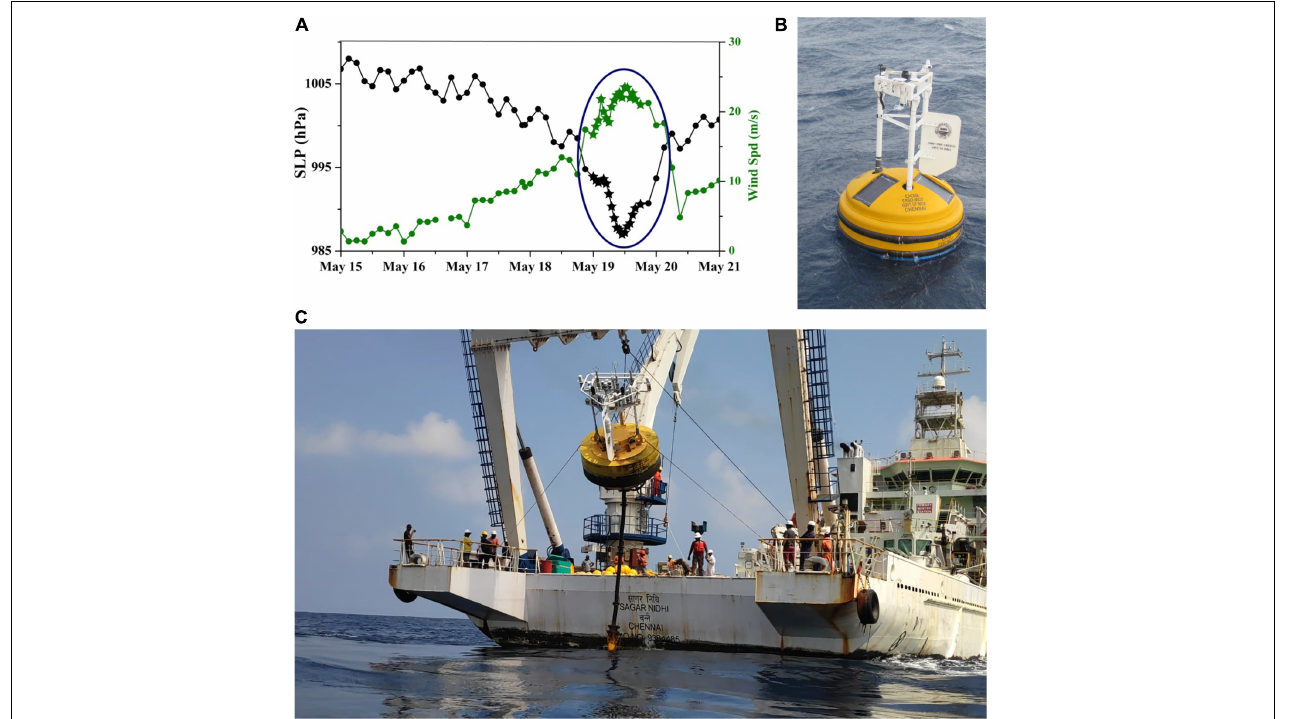
FIGURE 9 | (A) Time-series observations of air pressure and wind speed with high-frequency real-time data during cyclone AMPHAN in BoB, (B) the Indian buoy system with tripod mast deployed in AS, and (C) retrieval of the INCOIS flux mooring.